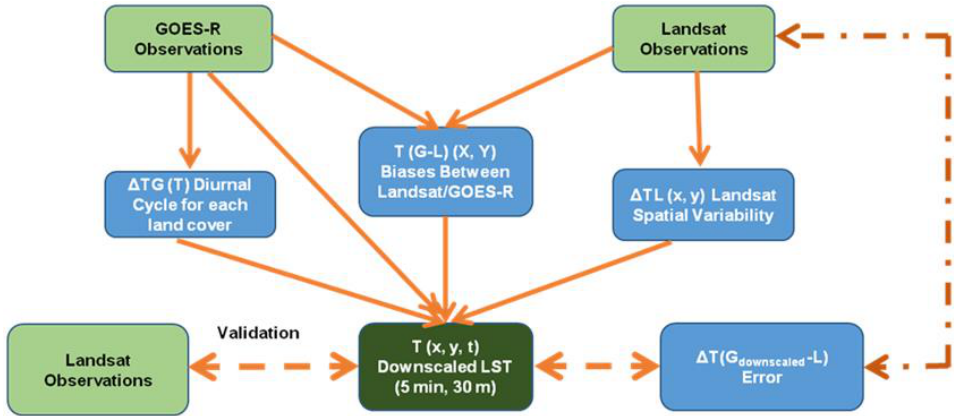
Figure 3. Flow chart of the Spatial Downscaling Method (SDM).